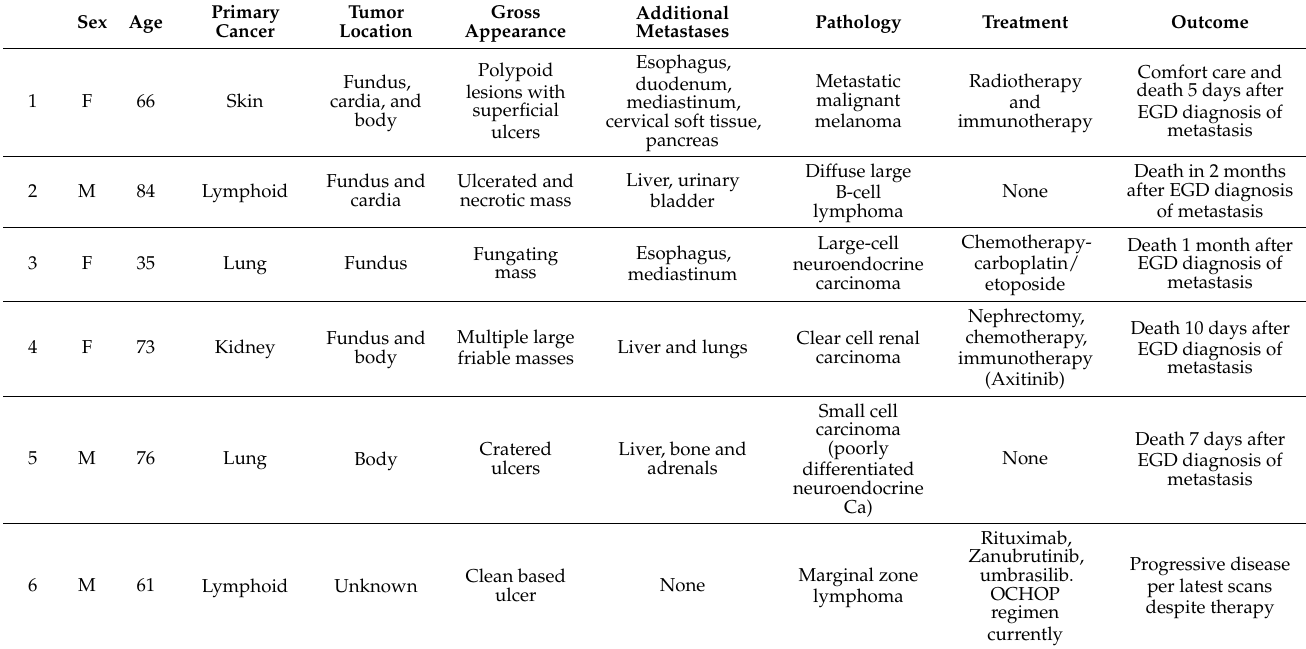
Table 1. Patient